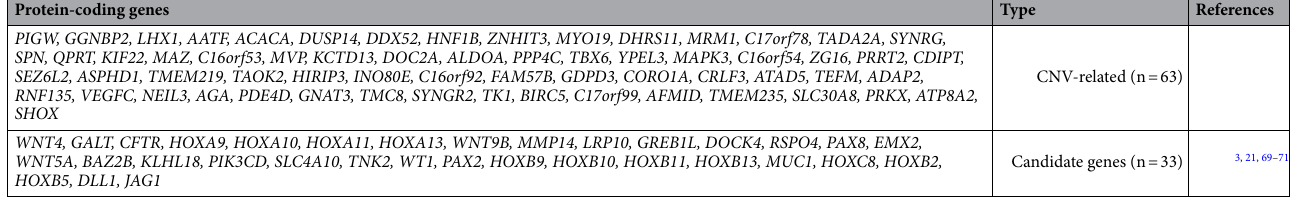
Table 2. PPI network analysis input genes.